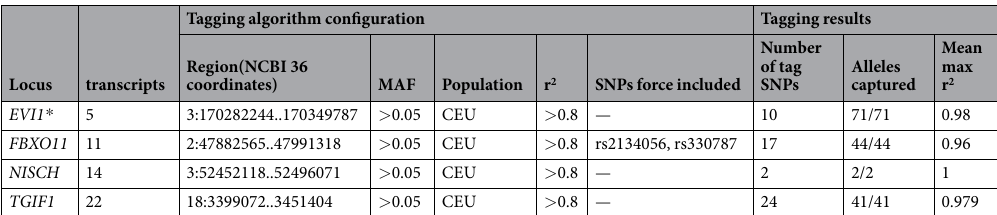
Table 2. Tagging algorithm. SNPs that were force included for FBXO11 were rs2134056, reported by Segade et al . 21 and rs330787 by Rye et al . 20 . * EVI1 is part of the MDS1/EVI1 cluster, renamed as MECOM by